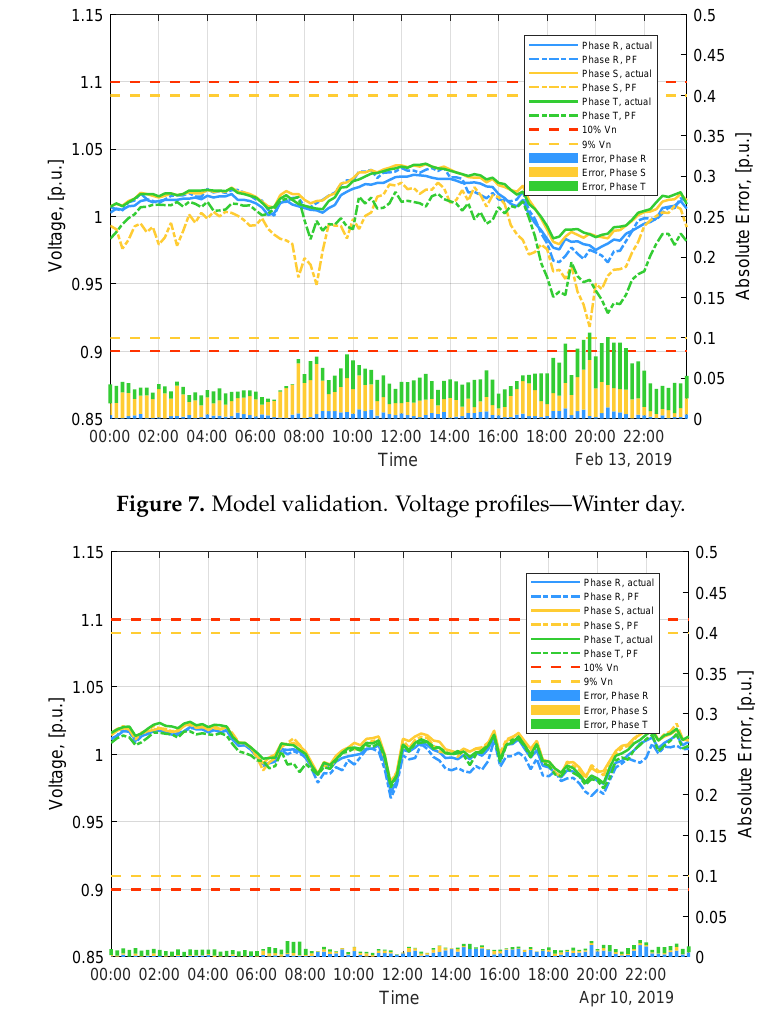
Figure 8. Model validation. Voltage profiles—Spring